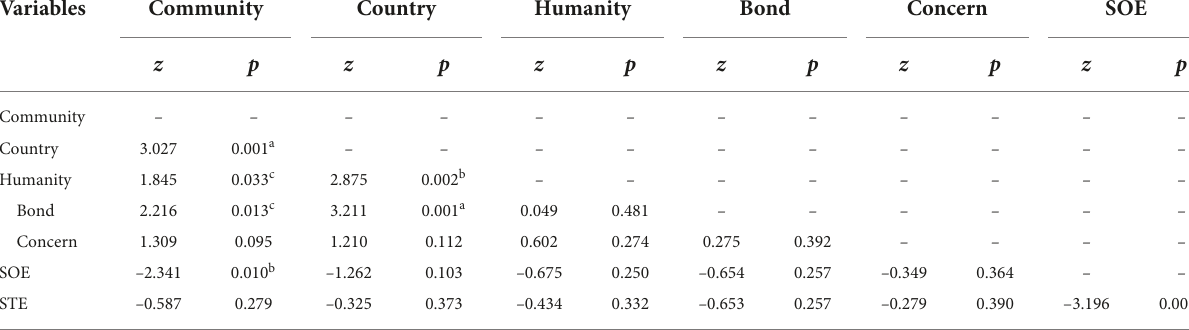
TABLE 7 Between-country comparison of correlations among the study